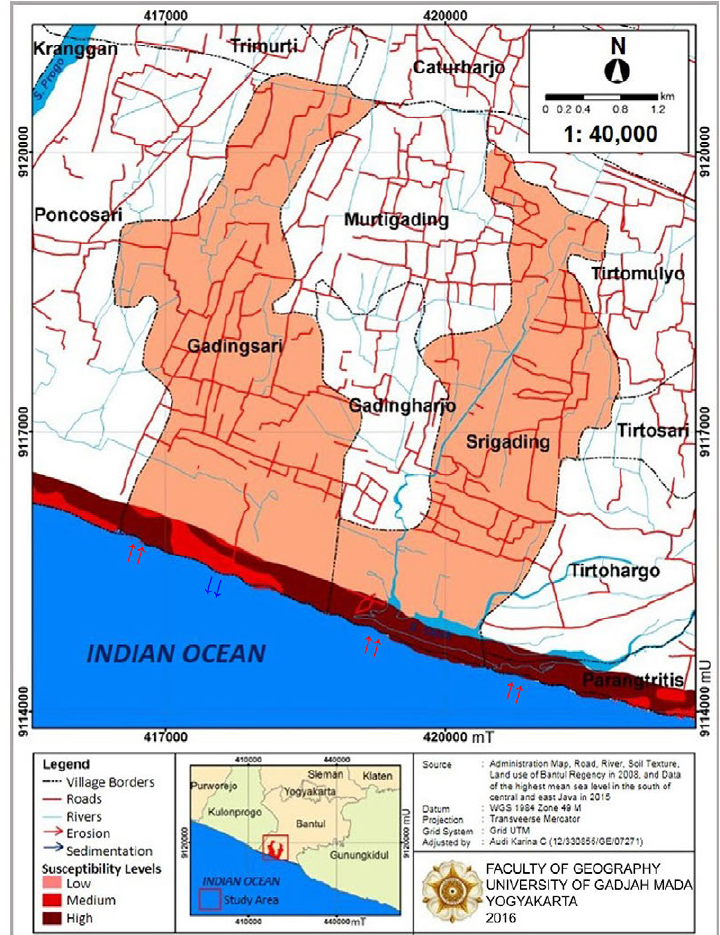
Fig. 2. The erosion susceptibility map of Samas Coast by Choirunnisa